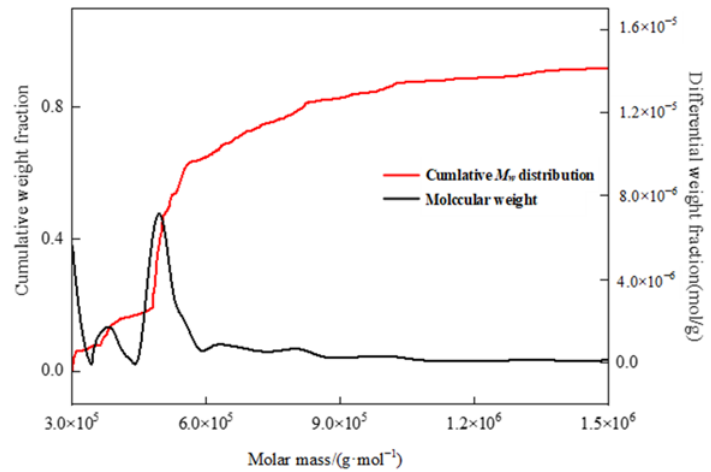
Figure 8. Cumulative distribution curves of poly (DMDAAC ‐ co ‐ DAMBAC) (9:1)’s efflux time and relative molecular mass.